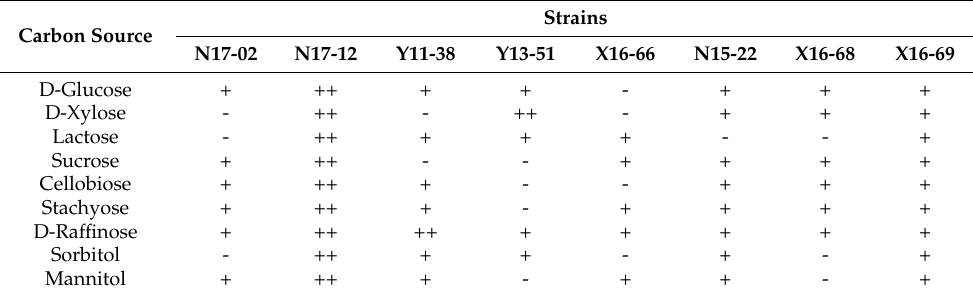
Table 7. The utilization of different carbon source by probiotic strains.